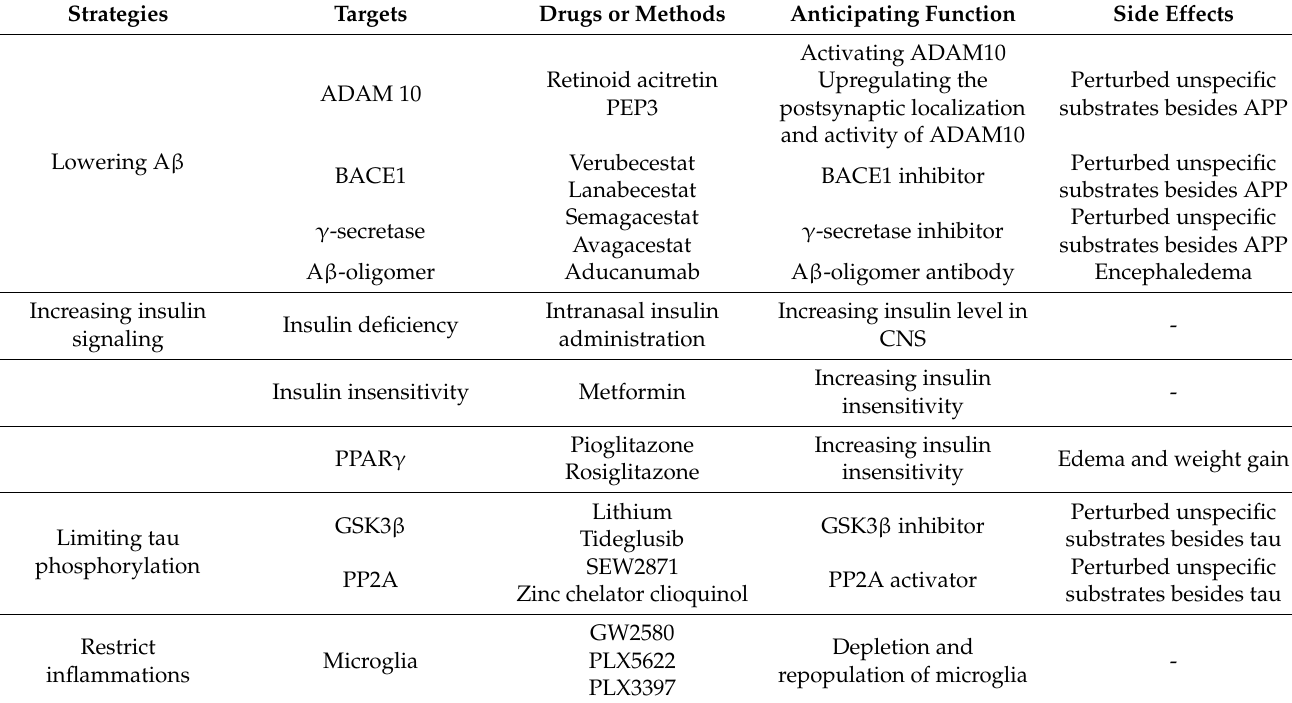
Table 1. Overview of different strategies for the treatment of AD.